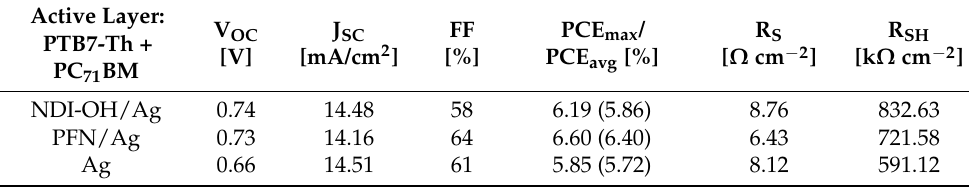
Table 1. Figures of merit for fullerene-based polymer solar cells (PSCs). Active layer PTB7-Th+ PC 71